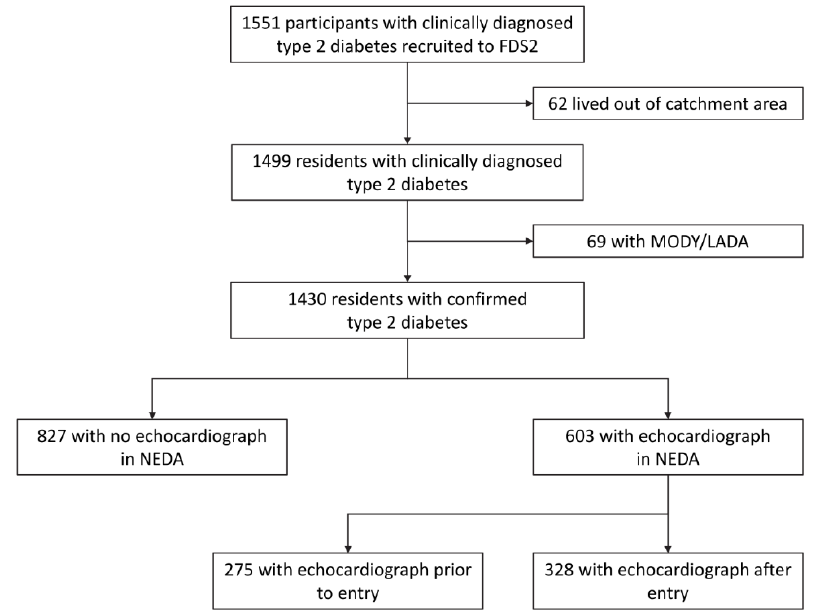
Figure 1. Consort diagram showing the number of Fremantle Diabetes Study Phase 2 participants included in the present sub-study.